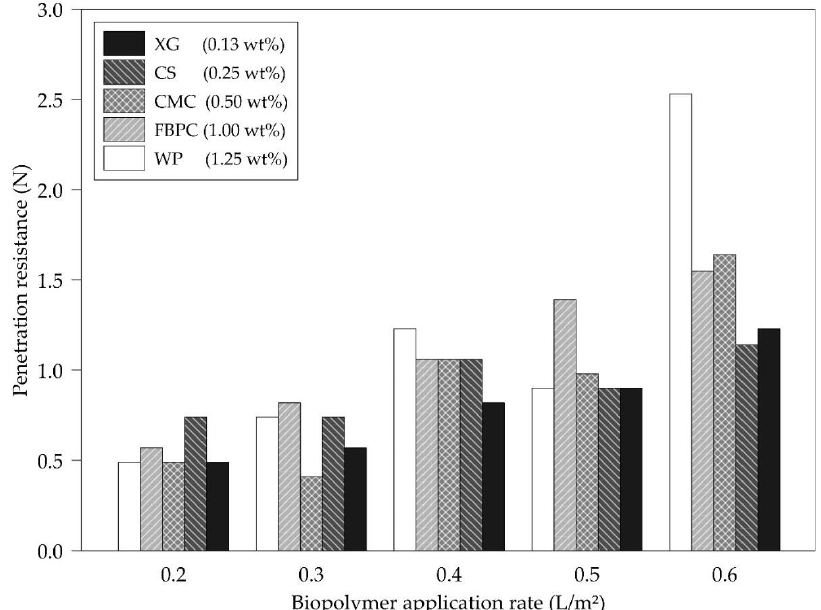
Figure 11. Penetration resistance of crusts from fine-grained silica sand samples performed after the fifth wind tunnel cycle on day 28. Biopolymers were applied at their respective plateau concentration determined in Phase 1. Each of the three prepared samples was penetrated at the top and bottom of the centre (n = 6). The numerical results are appended in Table A5.